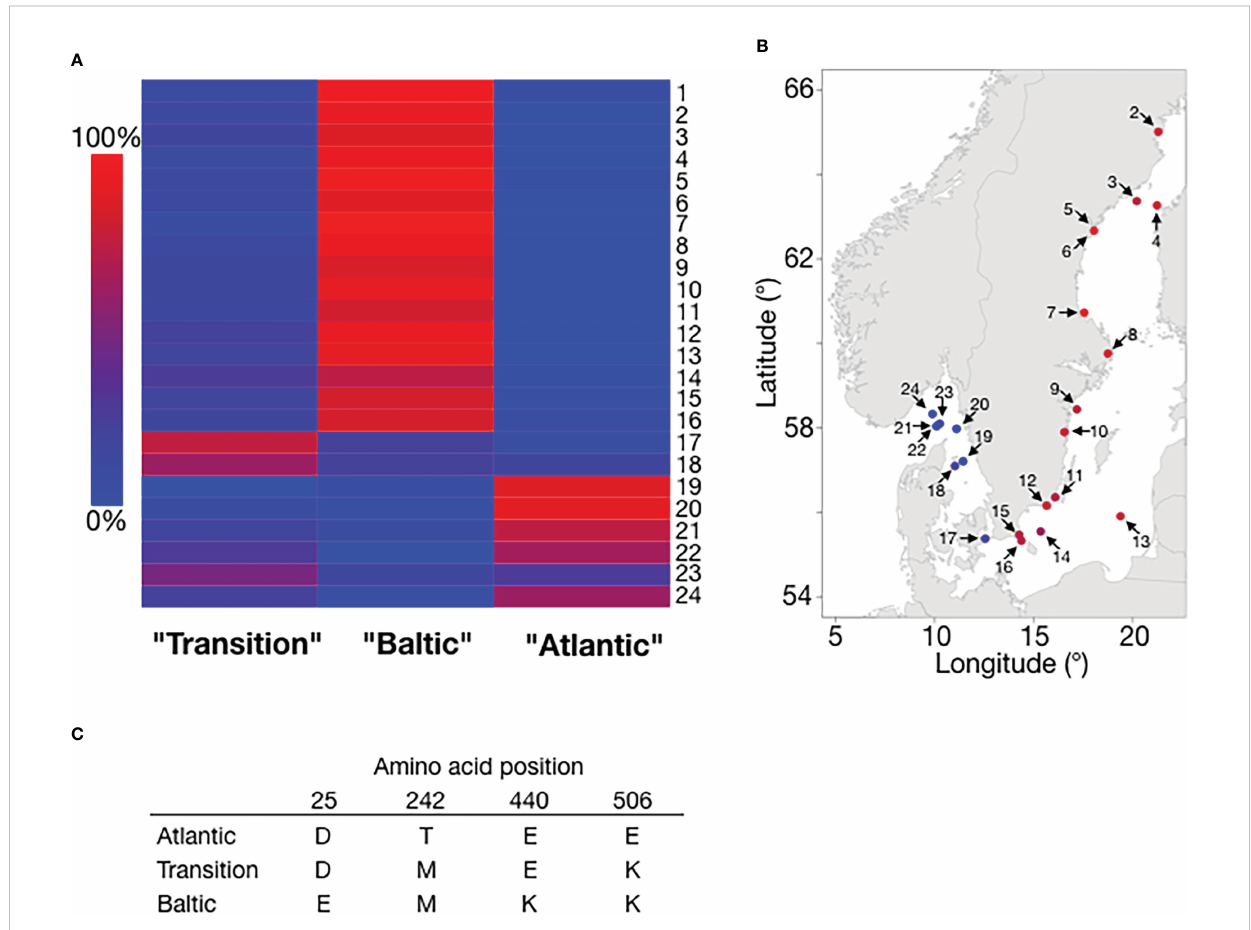
FIGURE 2 The frequencies of LRRC8C alleles show strong correlation with salinity. (A) Heatmap of the frequencies of the three LRRC8C alleles. Column labels are colloquial names for the common alleles based on their most prevalent location. Samples were collected and genotyped in the collaborative “ Forskarhjälpen ” project presented in Pettersson et al. (2019). Each row refers to a population sample (numbered 1-24) collected by one participating school and ordered by geographical location (see panel B ). Color indicates allele frequency. (B) Geographical presentation of the frequency of the Baltic allele (color code for allele frequency the same as in (A) . Sample labels correspond to (A) Sample (1) lacks a reported location, and is omitted. (C) Amino acid residues for the three alleles at the variable